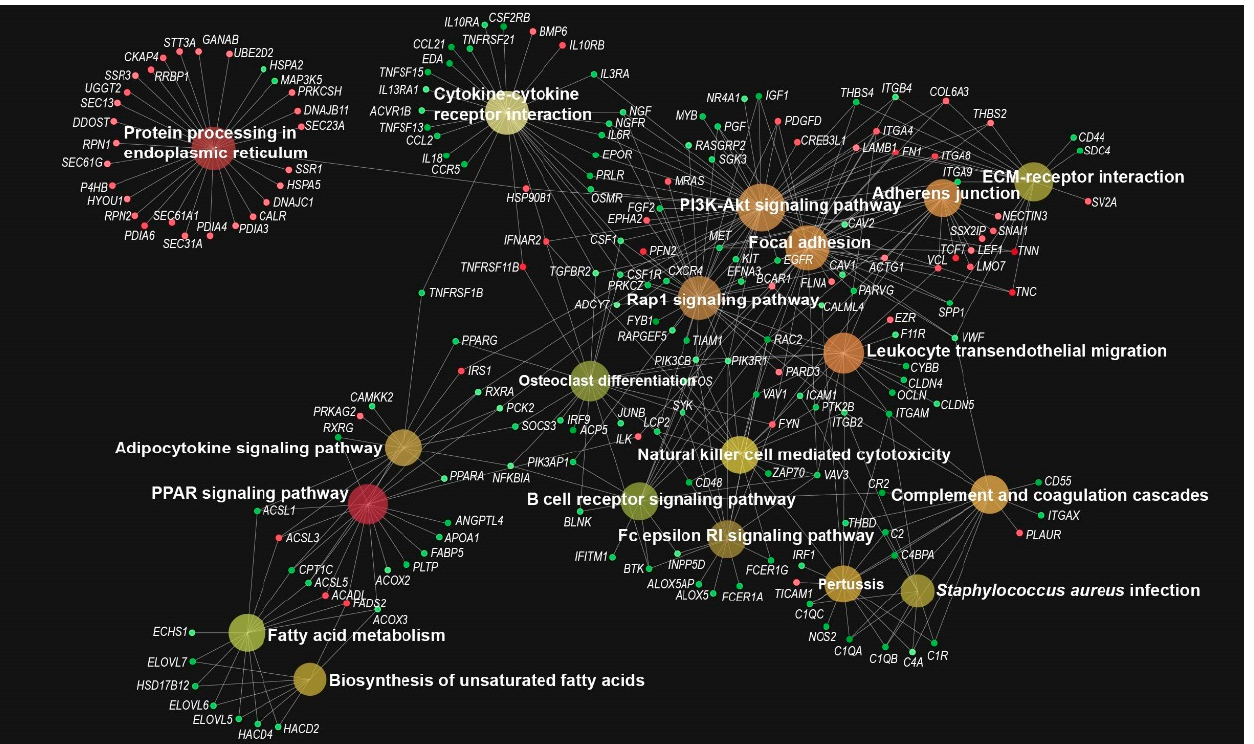
Figure 5. Identification of the transcriptional enrichment networks. The enrichment pathway was calculated using the gene set enrichment analysis. Each significantly enriched KEGG pathway is represented as a circle. Circle colors indicate the significance of the enriched KEGG pathways from minimum (red) to maximum (yellow). The circle size indicates the number of DEGs. Gene sets with overlapping genes are connected with an edge. Red and green nodes indicate up- and down-regulated DEGs in the 25(OH)D group compared with the Ctrl group. The network is displayed as the Bipartite layout.